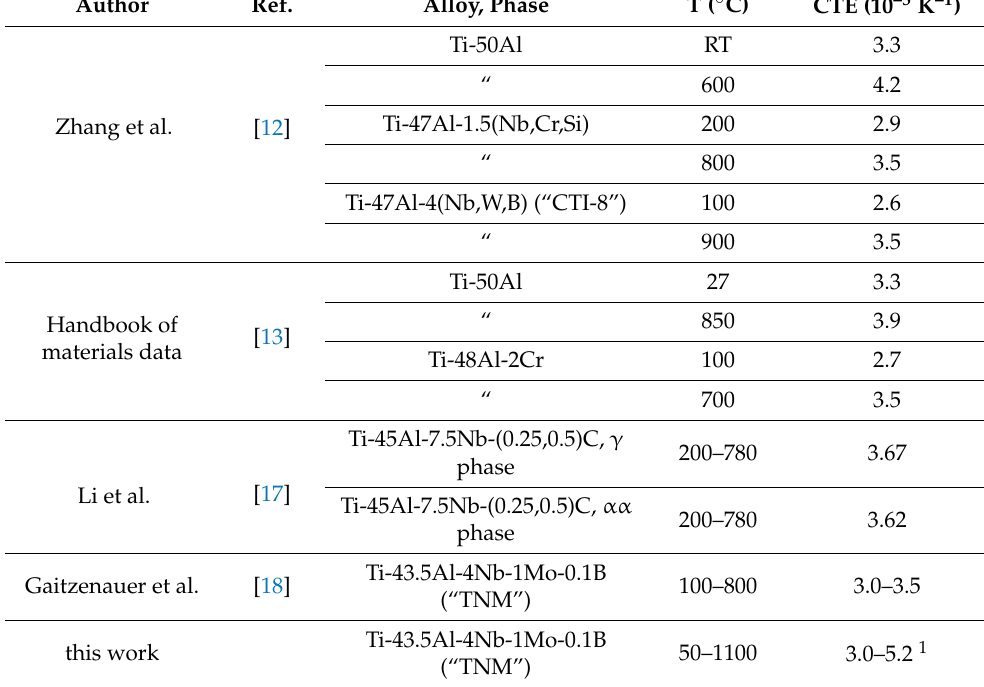
Table 2. CTE (volume expansion) values for various intermetallic TiAl alloys as reported in the literature. Where only the linear CTEs were given, the values were multiplied by 3 for comparison. Author